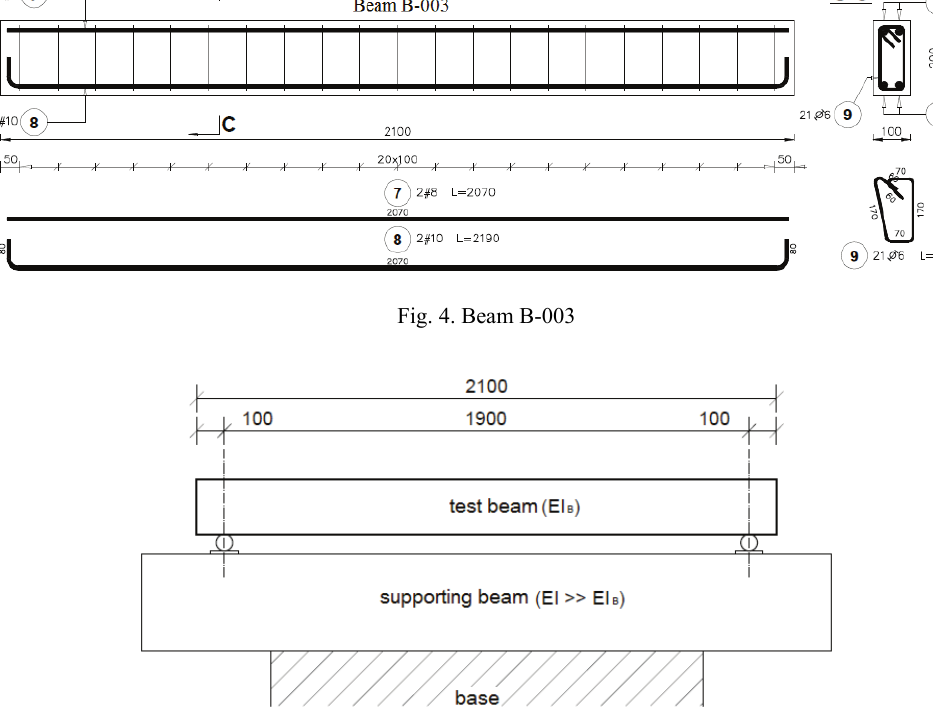
Fig. 5. Test stand. EI – stiffness of supporting beam, EI B – stiffness of test beam